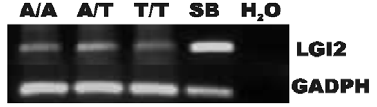
Figure 2. Expression of the mutant Lgi2 transcript is normal. Total RNA extracted from blood of a healthy (c.1552A/A), a carrier (c.1552A/T), and an affected (c.1552T/T) Lagotto Romagnolo , as well as from the cerebellum of a healthy (1552A/A) Saluki (referred as SB) was transcribed into cDNAs for amplification by PCR with Lgi2 exon-specific primers. The truncation mutation does not alter expression level of Lgi2 .